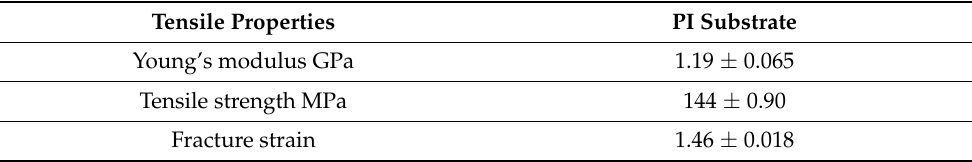
Figure 6. Stress–strain curve of PI substrate.